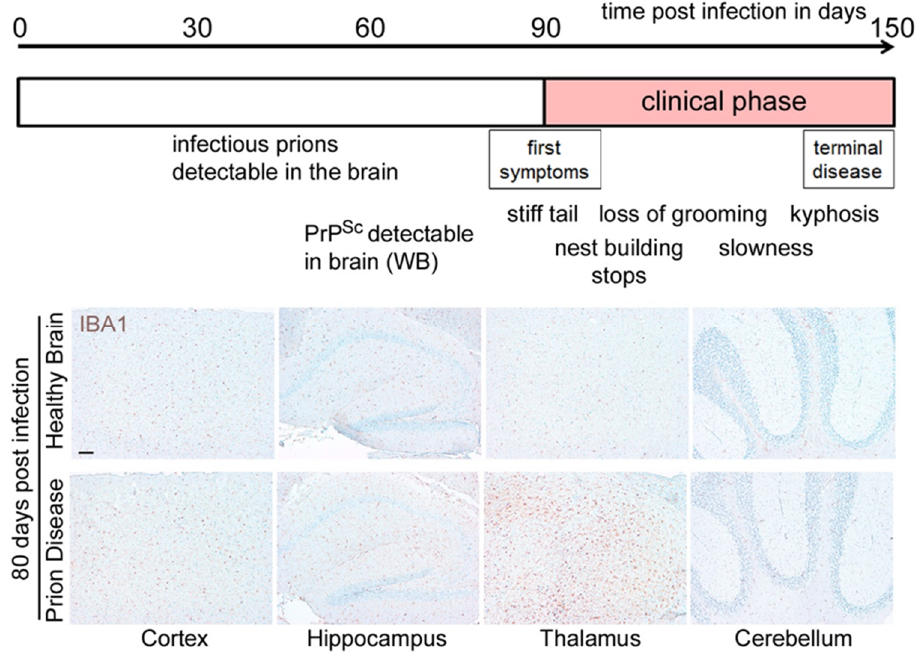
Figure 2. Prion disease course in the mouse model. Prion diseases are neurodegenerative diseases that can be easily experimentally transmitted by the inoculation of mouse-adapted prions (such as the Rocky Mountain Laboratory strain; RML inoculum) to the brains of mice. Disease onset and clinical course are relatively accurately predictable, eventually leading to terminal disease usually within 150 ± 5 days after high-dose intracerebral inoculation. RML 5.0 is a specific and very well- characterized passage of RML that was and is used in several laboratories [35]. After a latency period, in this model, prion infectivity is already detectable in the brain at 30 days post infection (dpi), and misfolded PrP Sc can be detected by Western blot (WB) at around 60 dpi. Symptoms appear around 90–100 dpi. Lower panel: The pan-microglia/monocyte marker ionized calcium-binding adaptor molecule 1 (IBA1) is shown at 80 dpi in different brain regions in comparison to the brain of a mock-infected control mouse (healthy brain). Note the region-specific change towards a reactive microglia phenotype in the thalamus in prion disease during the preclinical stage before the onset of symptoms, including an increase in microglia numbers [45–47]. Scale bar: 100 µm.